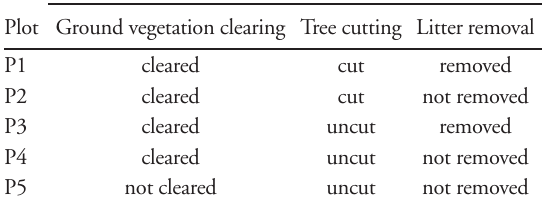
Table 1. Design for experimental vegetation disturbances. Manipulations on